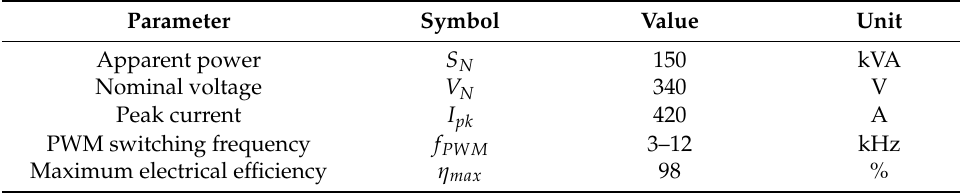
Table A1. Parameters of PIM.